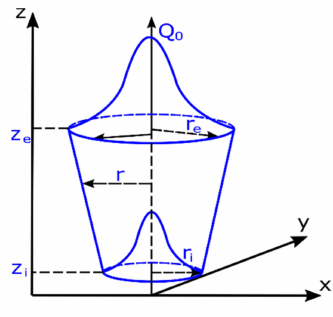
Figure 3. Three-dimensional conical heat source models